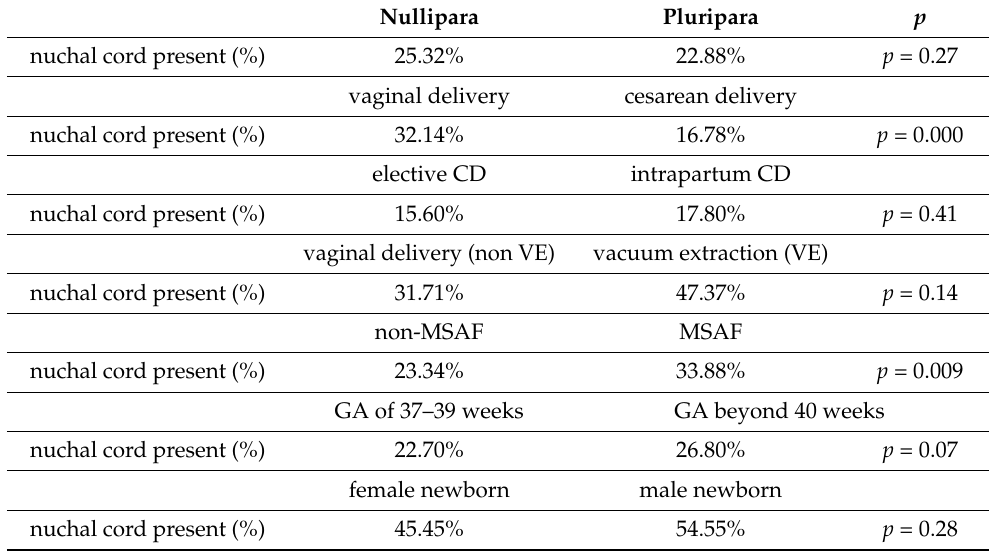
Table 2. Prevalence of nuchal cord in individual subgroups of patients. [CD—caesarean